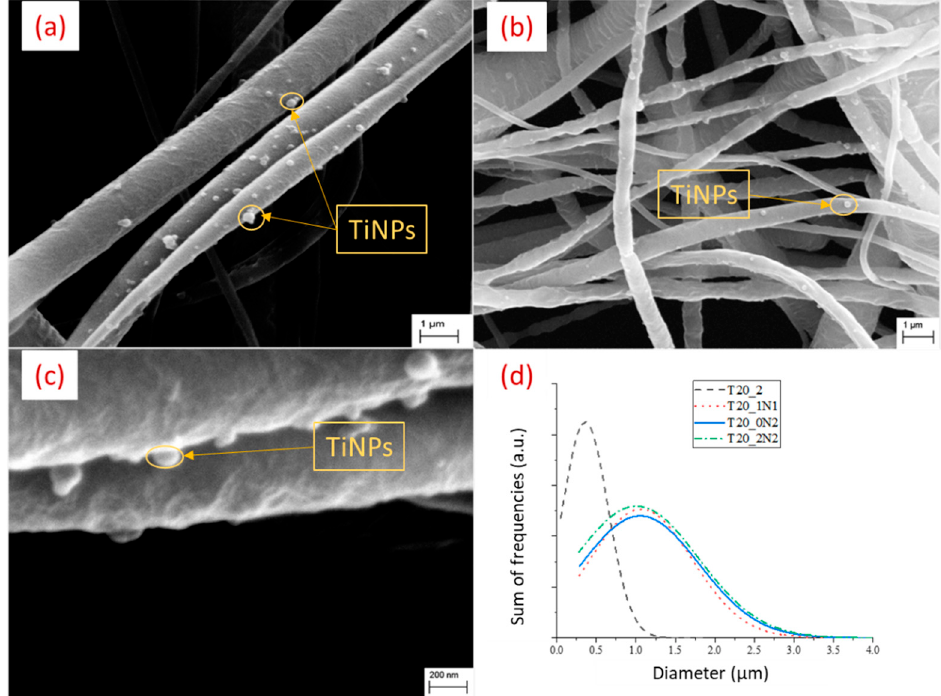
Figure 5. Ligand-free TiN NPs-functionalized PCL (20% w/v) nanofibers with various concentrations of TiN NPs in electrospinning solutions: ( a ) 1 mL (0.15 mg L − 1 ), T20_1N1; ( b ) 2 mL (0.15 mg L − 1 ), T20_0N2; ( c ) 2 mL (0.45 mg L − 1 ), T20_0N6; ( d ) statistical analysis of nanofibers’ diameter measured using ImageJ. Adapted from Ref. [157].